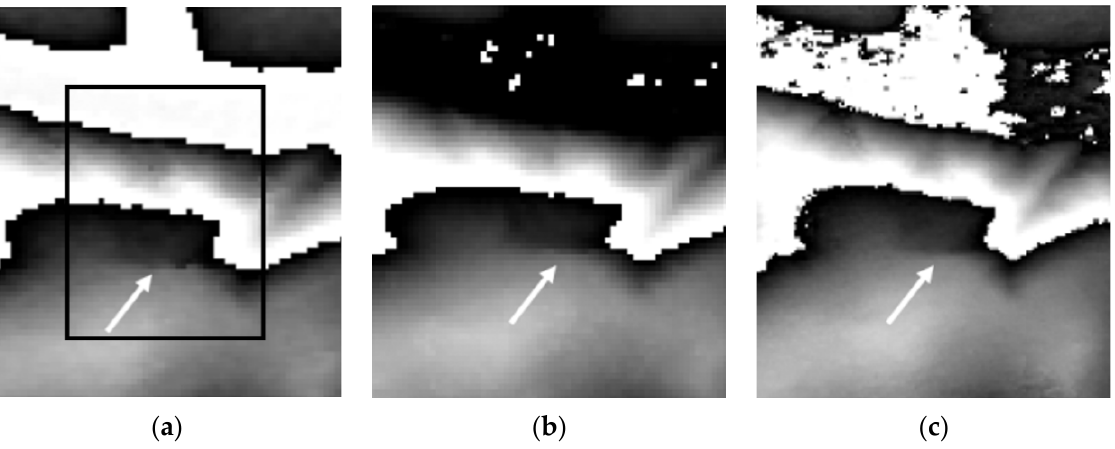
Figure 13. Fragments of DEM for the landslide area: ( a ) SRTM (black rectangle marks the borders of images from Figure 12); ( b ) World3D DEM; ( c ) TanDEM-X. Arrows mark the main scarp. The framework shows the location of the image fragments from Figure 12.